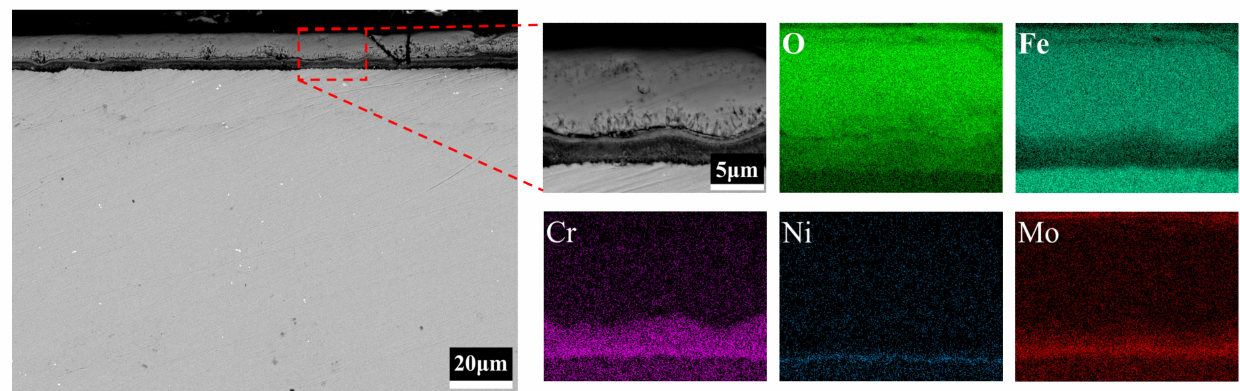
Figure 6. BSE-EDS maps of 3Cr3Mo2NiW steel